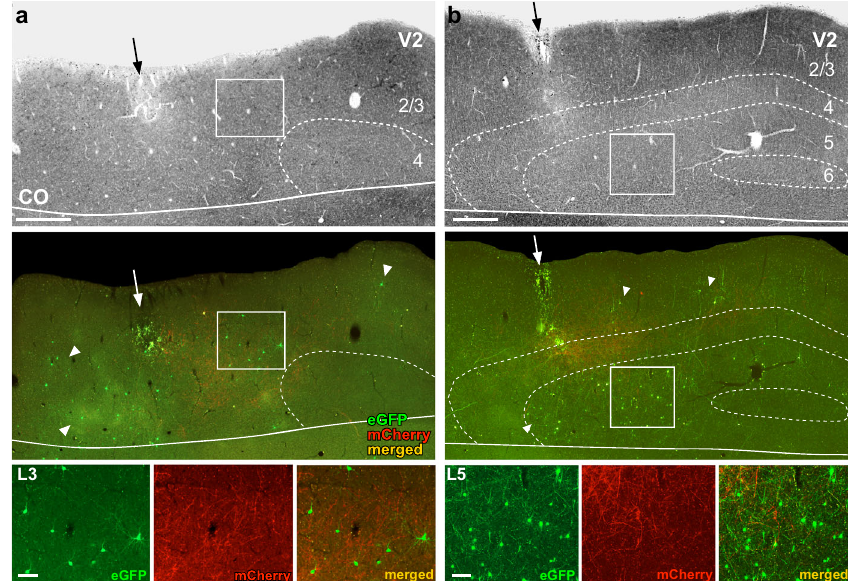
Fig. 3 V2 injection sites and resulting GFP-label in V2. Case MK405. a Image of a tangential section through V2 L1 – 4 stained for CO (Top) after being imaged for mCherry and GFP fl uorescence (Middle). The middle panel shows the merged fl uorescent channels. Arrows: V2 injection sites; white arrowheads point at some GFP-labeled input neurons. Red fi bers are the terminals of V1 → V2 neurons in L3 – 4. Solid white contour: V1/V2 border (V1 is below the border). The region inside the white box is shown at higher magni fi cation in the bottom panel. Other conventions as in Fig. 2. Bottom: higher magni fi cation of GFP-labeled V2 input cells in L3, shown under GFP or mCherry fl uorescence, and merged, as indicated. Scale bar: 100 µ m. b Same as in panel ( a ), but for a tangential section through V2 L1 – 6 showing denser GFP label in L5. Scale bars in ( a , b ): 500 µ m (Top, Middle), 100 µ m (Bottom). Supplementary Fig. 1 shows additional images illustrating the distribution of the GFP label across V2 layers. Results in ( a , b ) are representative of injection sites made in three independent cases with similar results.